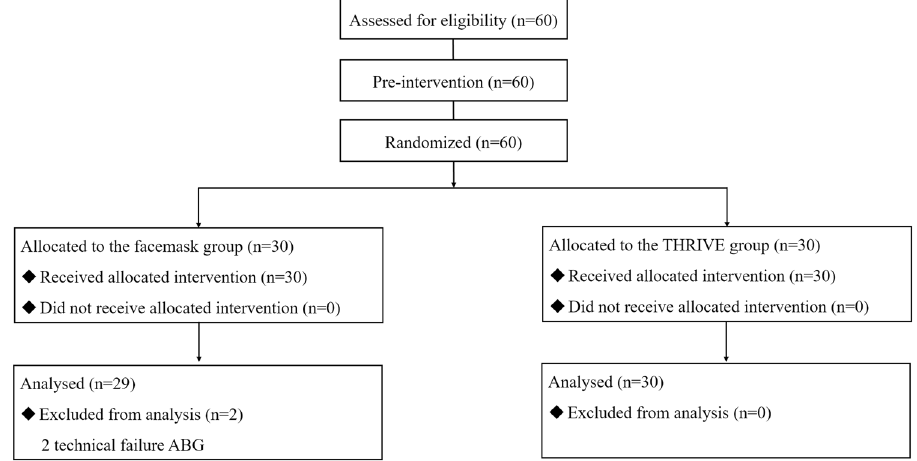
Figure 1. CONSORT diagram of study recruitment. THRIVE, transnasal humidified rapid insufflation ventilator exchange; ABG, arterial blood